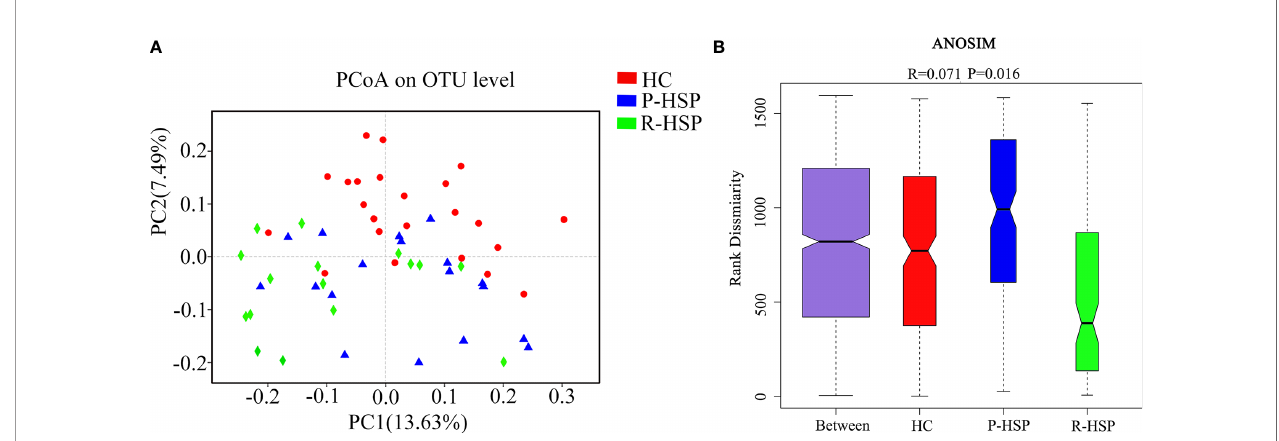
FIGURE 2 | Comparison of b -diversity indexes between patients with primary HSP and recurrent HSP and healthy controls. (A) PCoA analysis was based on unweighted UniFrac distance for bacterial communities. The closer the samples, the more similar the groups were. PCoA analysis showed the differences in the gut microbial composition between the three groups. (B) Analysis of similarities (ANOSIM) was based on the unweighted UniFrac distance between the groups. The ANOSIM that generated R test statistics ranging from − 1 to 1 was used to measure clustering of the samples patient-wise. A positive R-value indicates greater within-group similarity than between-group similarity, with greater magnitudes of the R-value suggesting stronger sample clustering. An R-value of 0 indicates no clustering of the samples, whereas a negative R-value suggests greater between-group resemblance than within-group similarity. The ANOSIM demonstrated clear differences in the gut microbial composition between the two HSP groups and the healthy control group (R = 0.071, P =